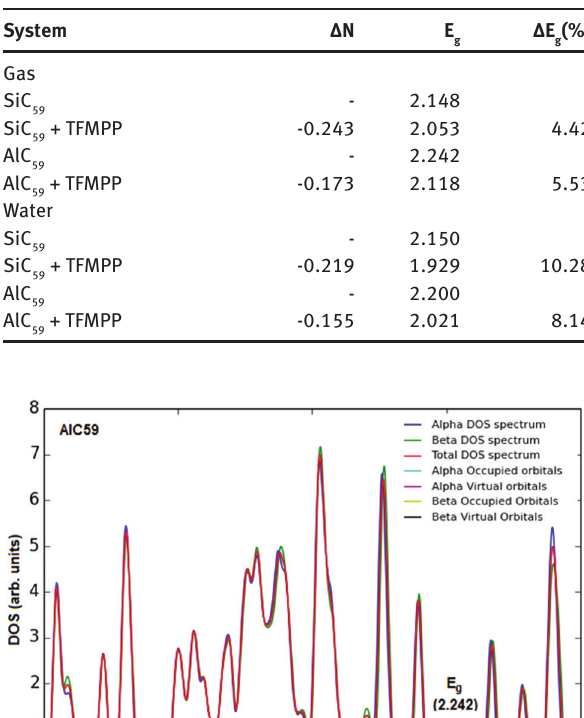
Table 3: Energy gap and charge transfer rate of the studied systems.